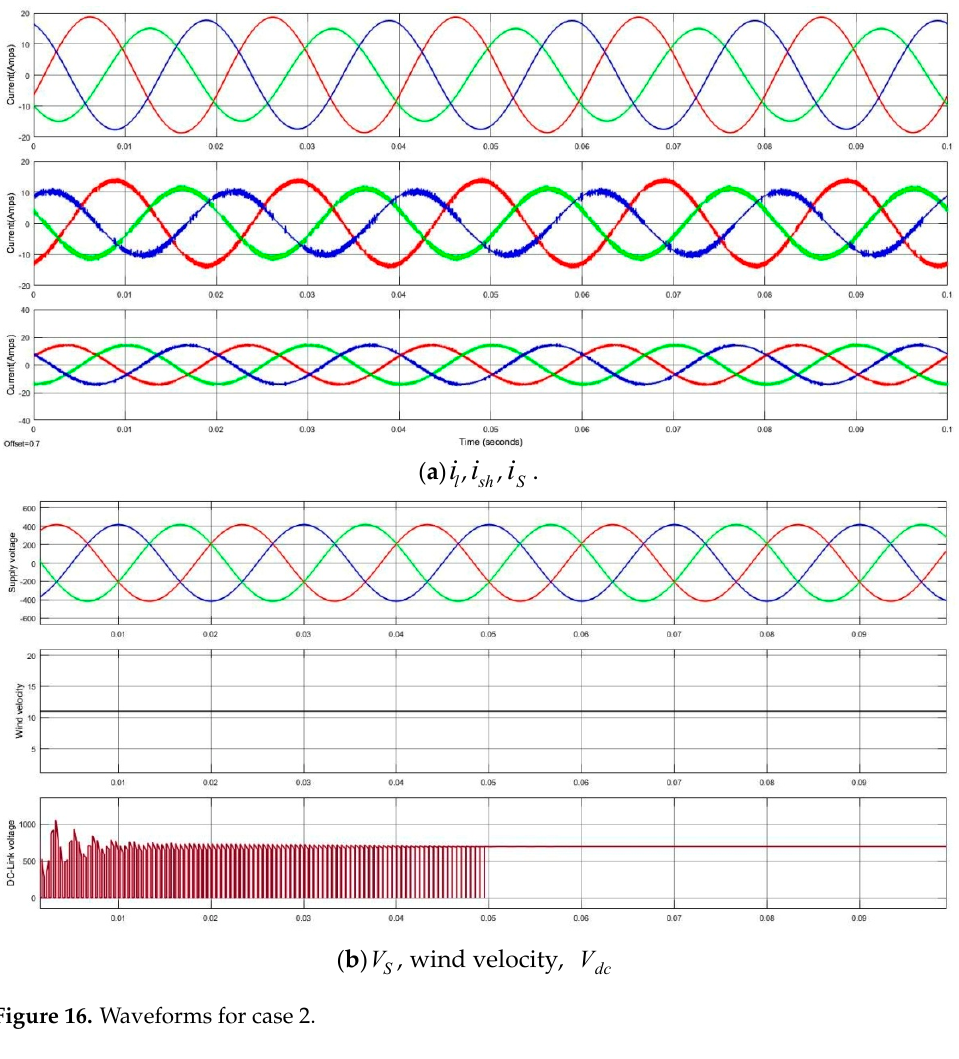
Figure 16. Waveforms for case 2.